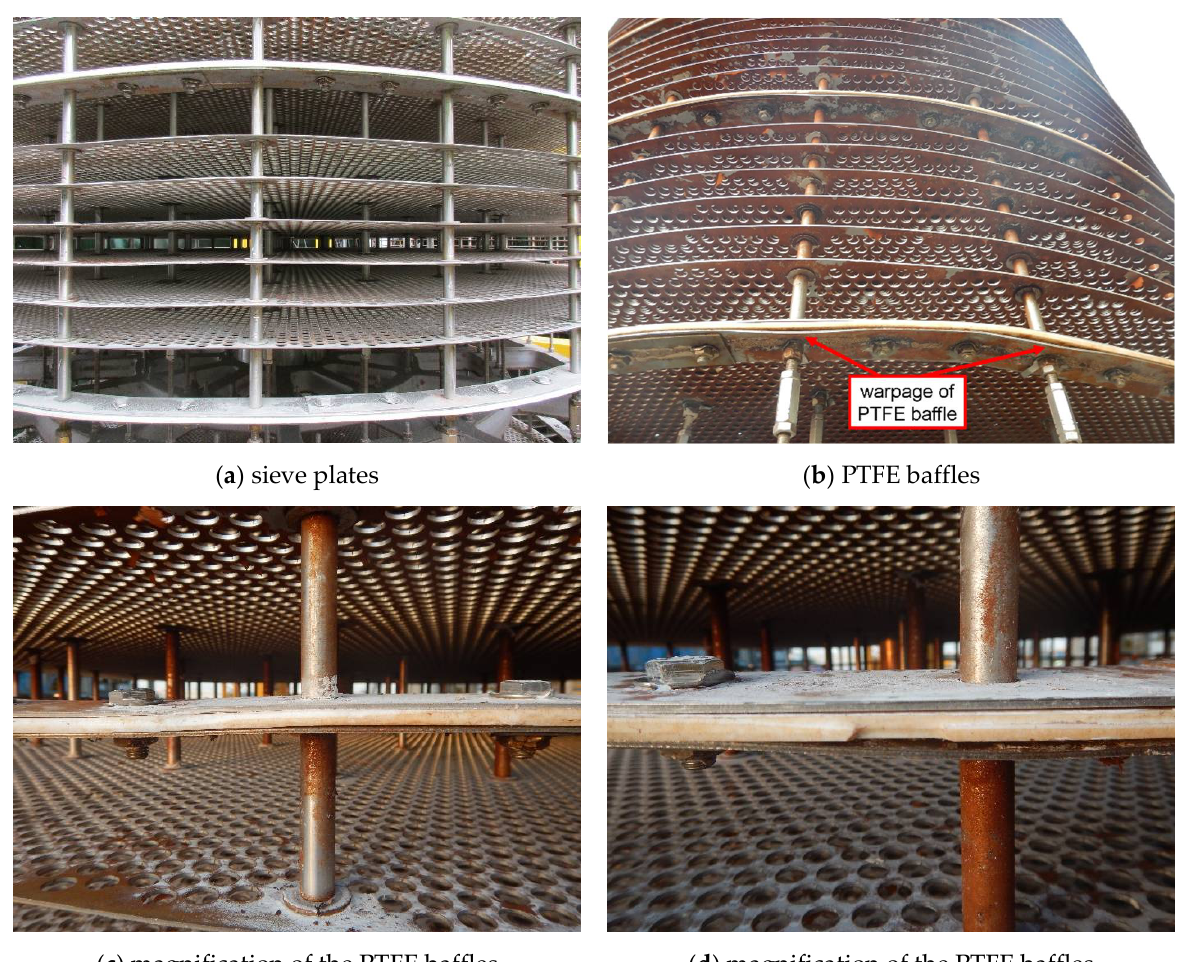
Figure 13. External appearances of warpage on the sieve plates and the PTFE baffles.